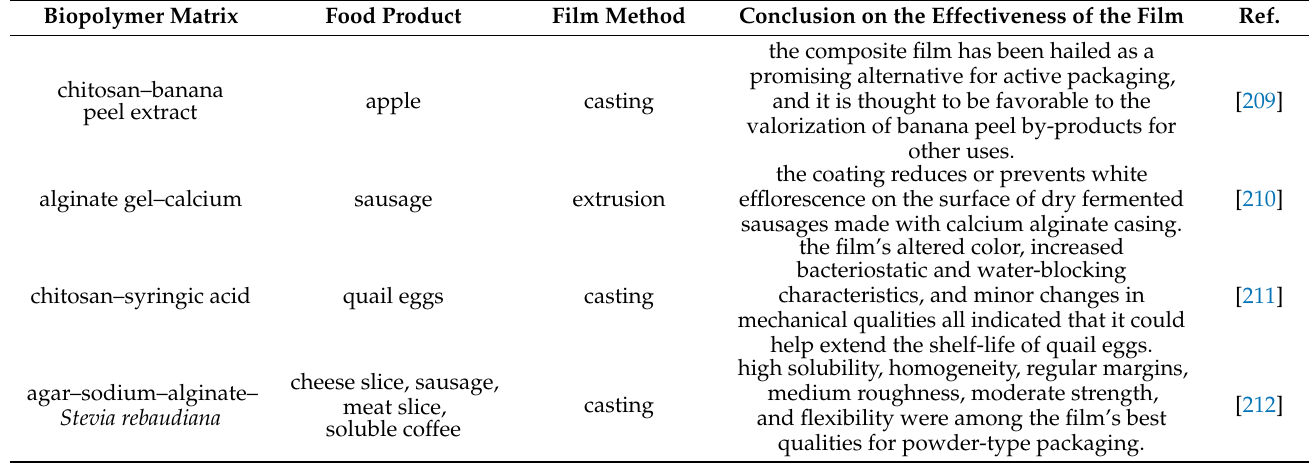
Table 2. Film formation methods for food products from marine biopolymers.